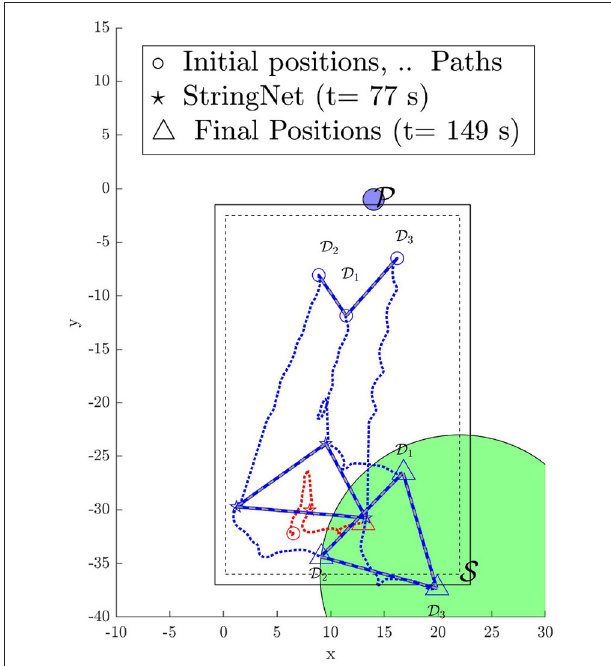
FIGURE 14 | Paths traversed by the quadrotors during StringNet Herding (The dotted blue lines denote the paths of the defenders while the red denote that of the attackers. The solid blue lines with white dashes in them denote the string barrier assumed between the quadrotors). FIGURE 15 | Snapshot of the quadrotors after enclosing and herding phases